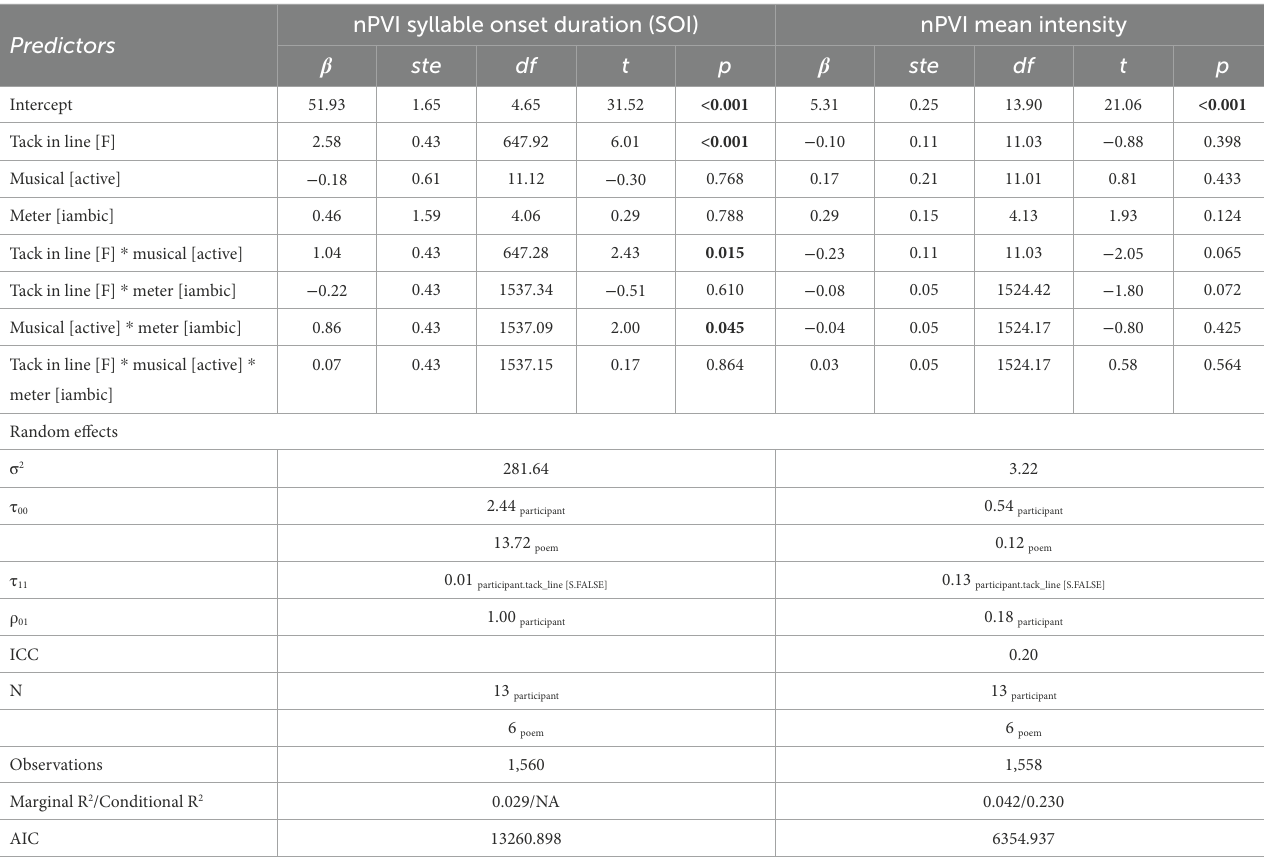
TABLE 3 Combined table for nPVI SOI and nPVI mean intensity for lines with and without tacks.